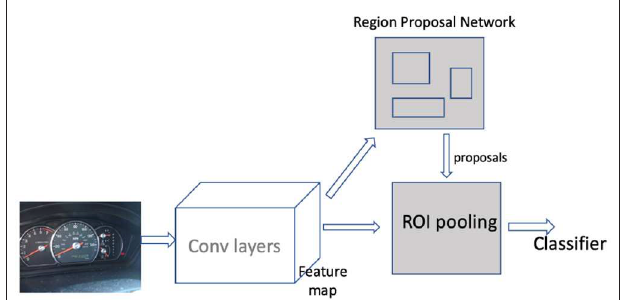
FIGURE 1 | Faster RCNN detector.